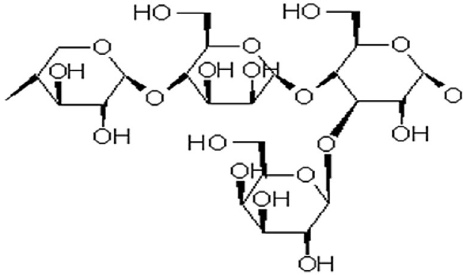
Fig. 2 Molecular structure of hemicellulose